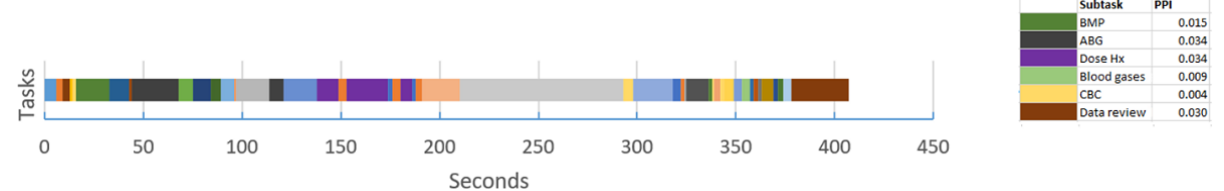
Figure 12. An example of proportion per instance calculated on the basis of the time belt from Figure 11. Proportion per instance for certain subtasks have been calculated in the small table to the right as examples. PPI: proportion per